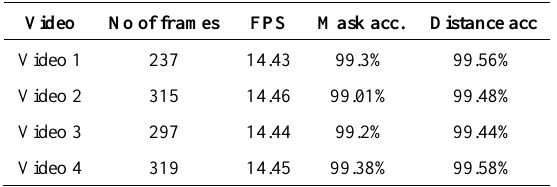
Table 4. Evaluation of the proposed model on the test